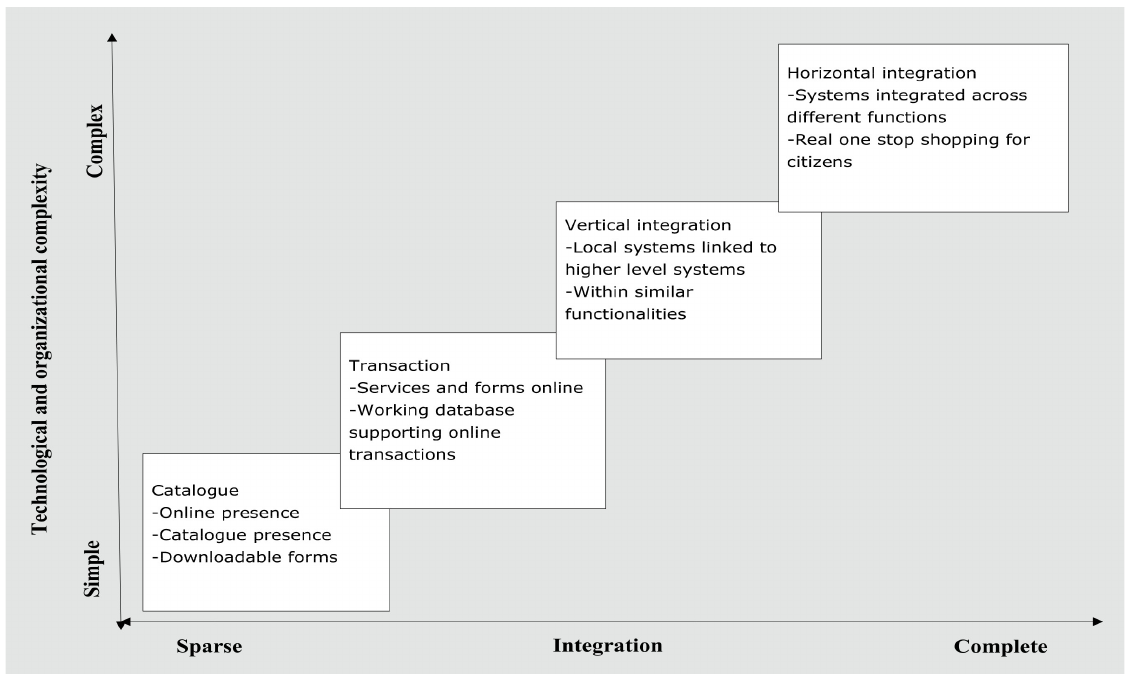
Figure 1. The Layne and Lee model